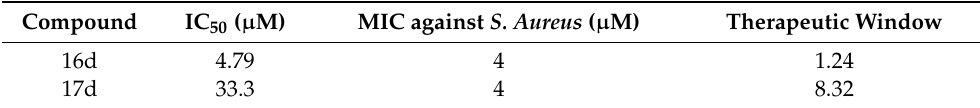
Table 2. IC 50 value of compounds against MRC-5 normal human lung fibroblasts and their therapeutic indices with respect to S. aureus